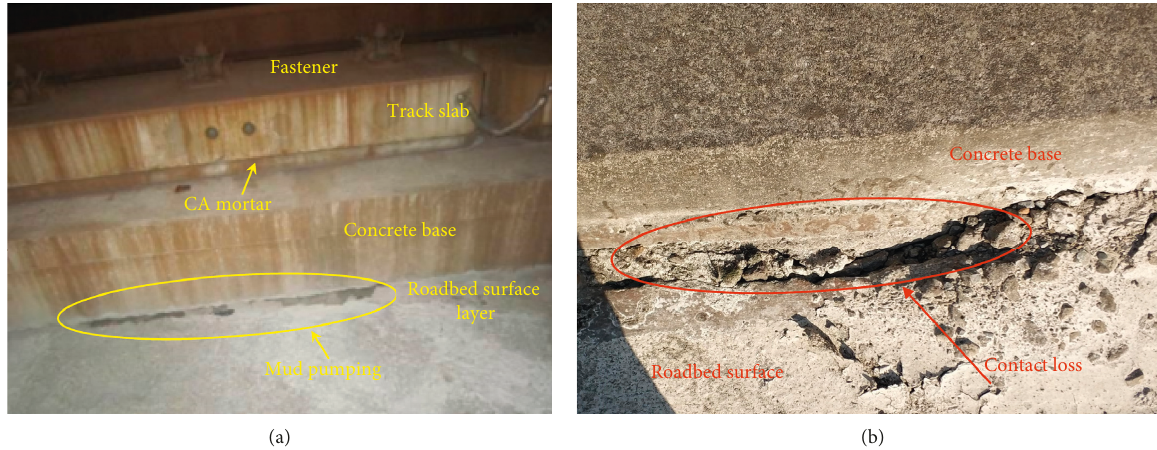
Figure 1: Mud pumping and associated contact loss of nonballasted track in a high-speed railway: (a) mud pumping and (b) an enlarged view of the contact loss between the concrete base and the roadbed surface.